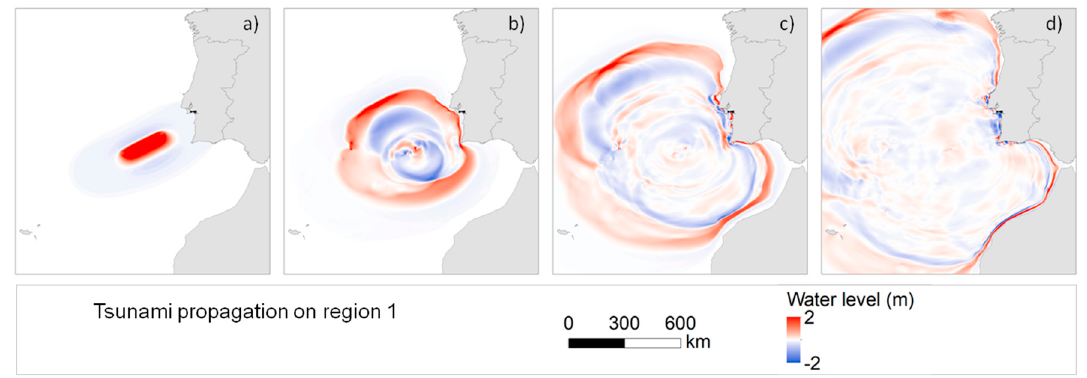
Figure 6. Tsunami propagation snapshots of region 1 for the 1755 tsunami: ( a ) initial sea surface displacement; ( b ) 20 min; ( c ) 40 min; ( d ) 60 min.